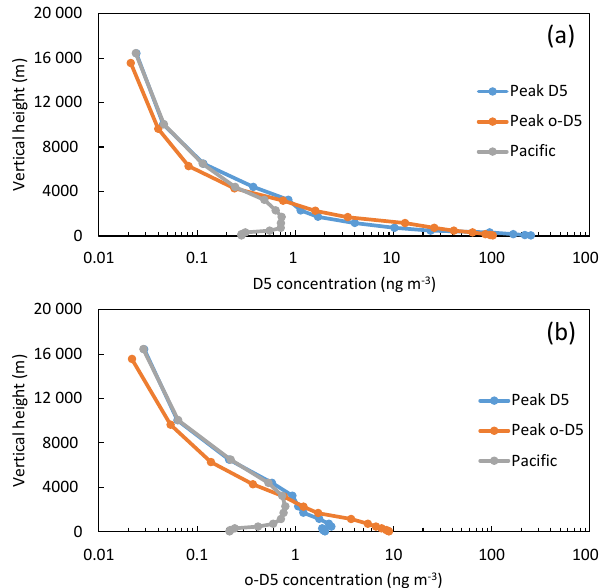
Figure 9. Monthly averaged vertical profiles for grid cells near Los Angeles. Plot (a) shows D 5 and (b) o-D 5 model concentrations. Grid cells refer to the location of maximum July D 5 , maximum July o-D 5 , and a grid cell over the Pacific